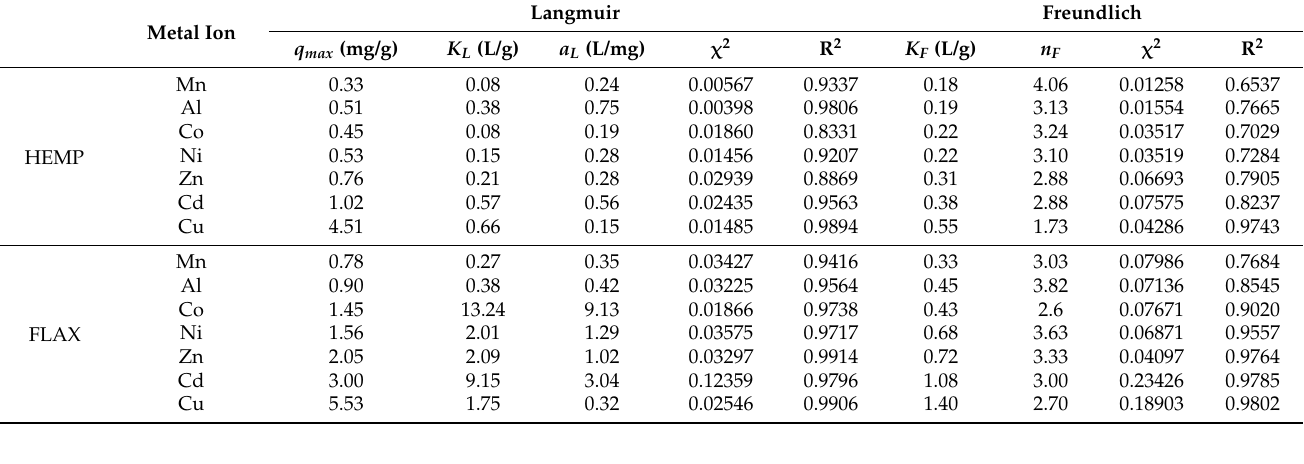
Table 2. Summary of the Langmuir and Freundlich isotherm constants and comparison of linear regression coefficients of determination (R 2 ) and chi-square test statistics ( χ 2 ).